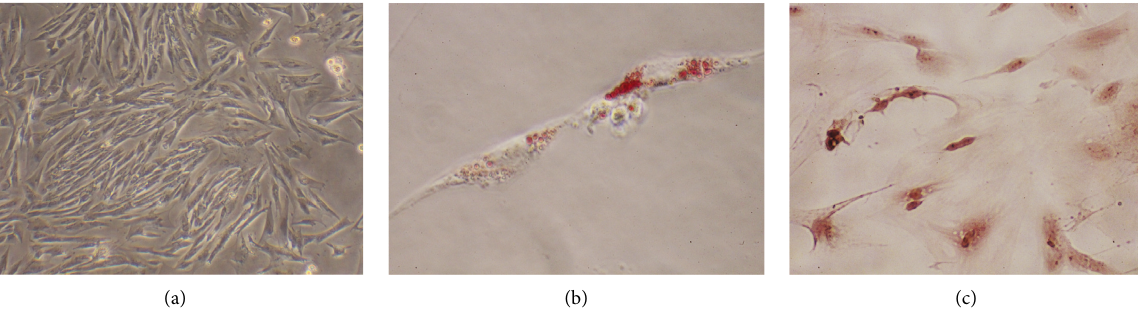
Figure 4: Characterization of adipose tissue-derived mesenchymal stem cells (ADSCs). (a) In passage three, the ADSCs exhibited a spindle- shaped fibroblastic morphology (magnification, × 100). (b) After dyeing with oil red O, the lipid droplets in the cells were stained red (magnification, × 400). (c) After staining with alizarin red dye, calcified nodules in cells were stained black (magnification, ×